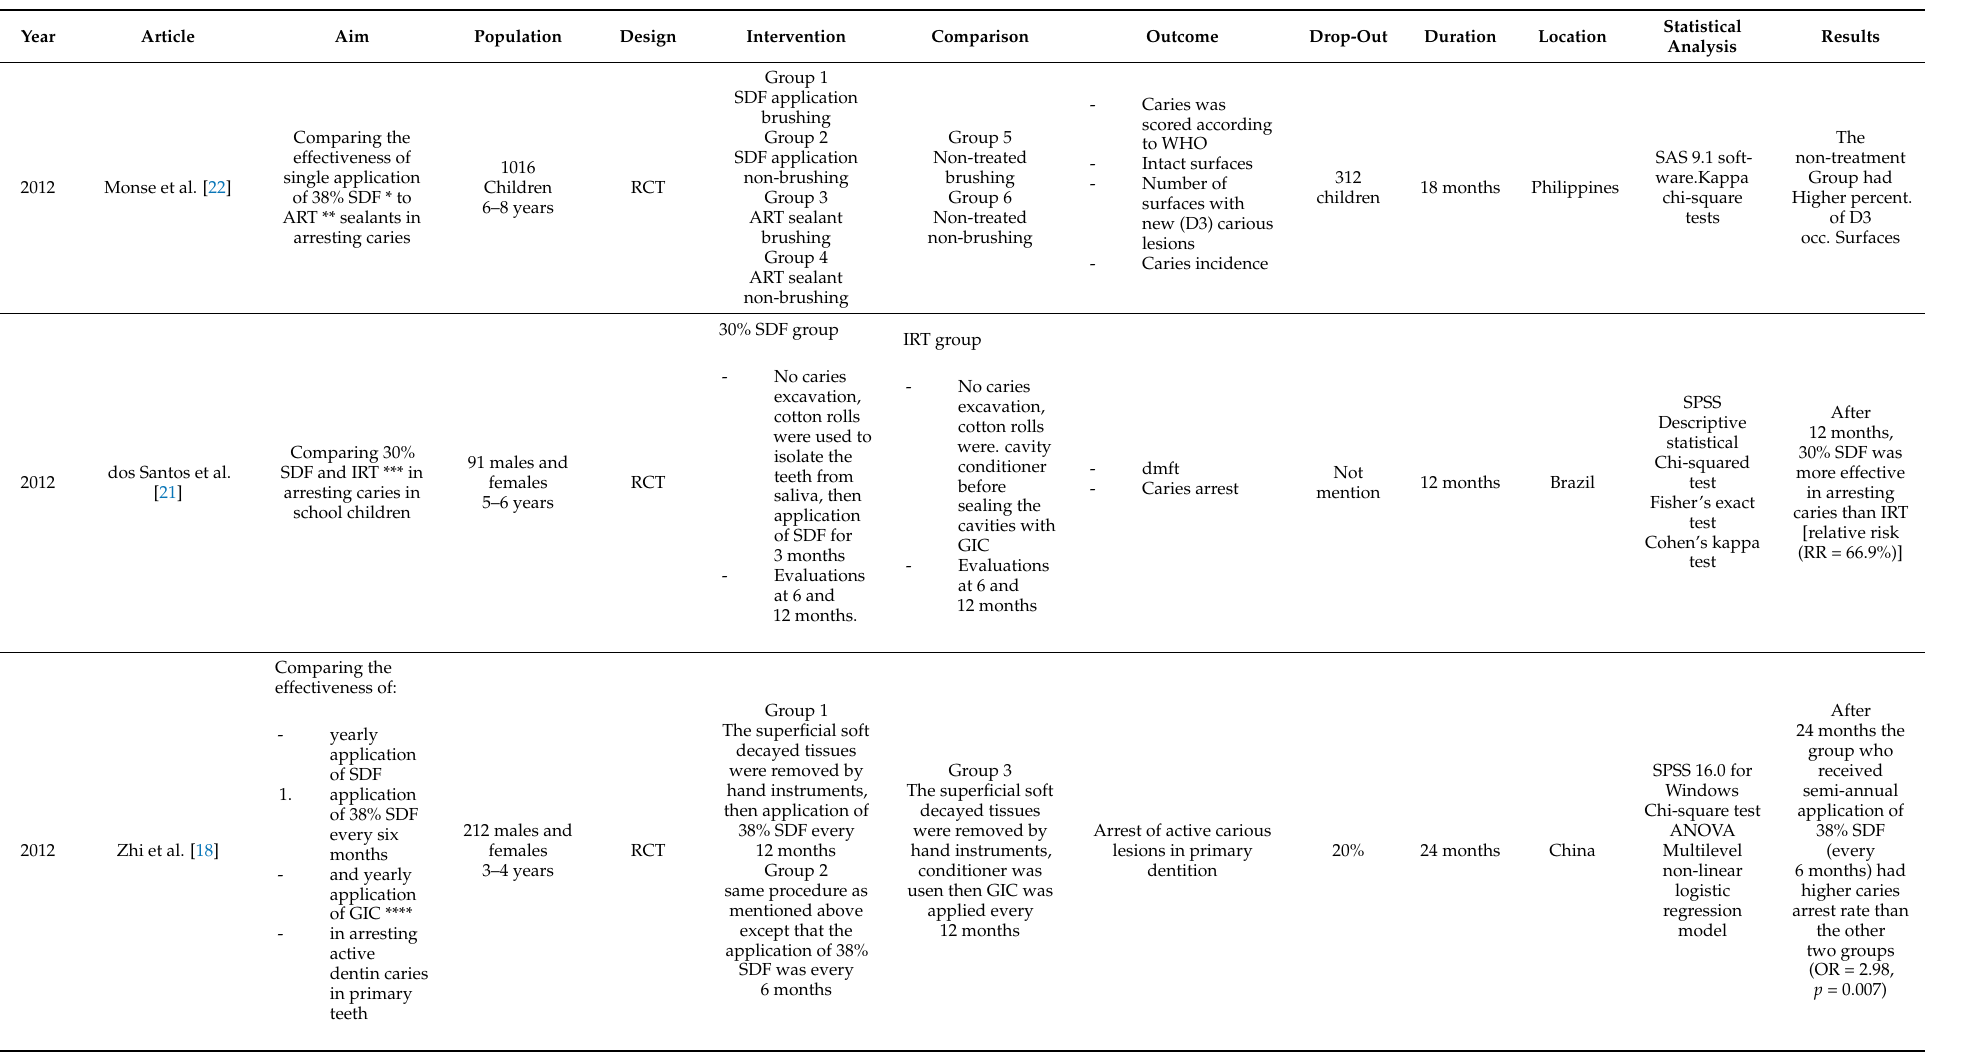
Table 1. Data extraction sheet and characteristics of included